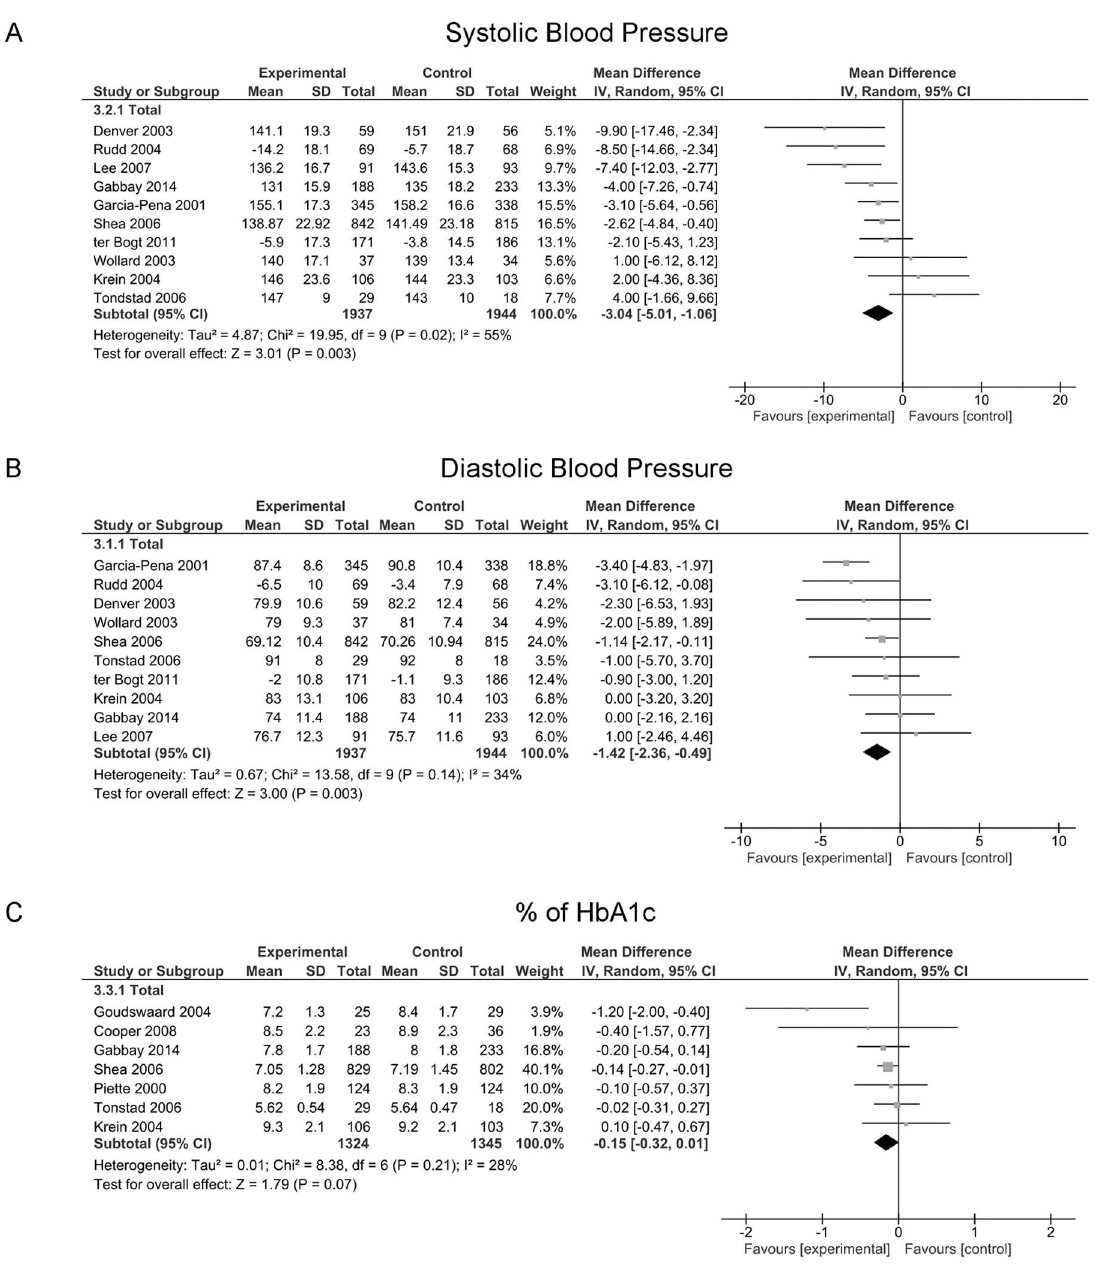
Fig 2. Comparison of the effect of nurse-led support interventions and usual care on the reduction of some Observer Related Outcomes (OROs): Systolic Blood Pressure,Diastolic Blood Pressureand Hb1Ac * . * Only for